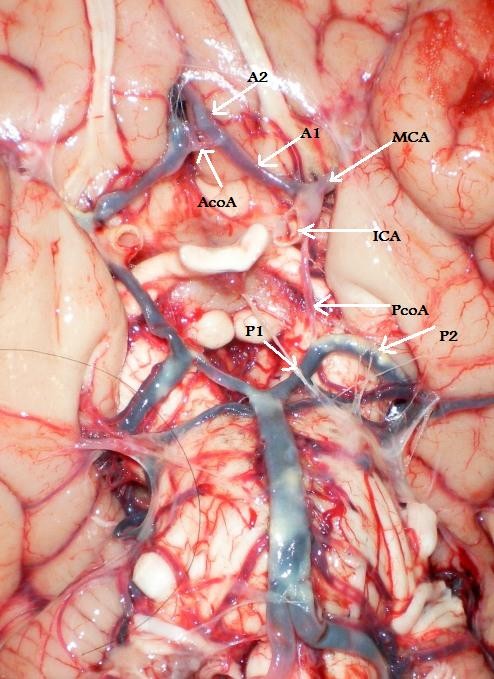
(Type 1) - "Typical CW".